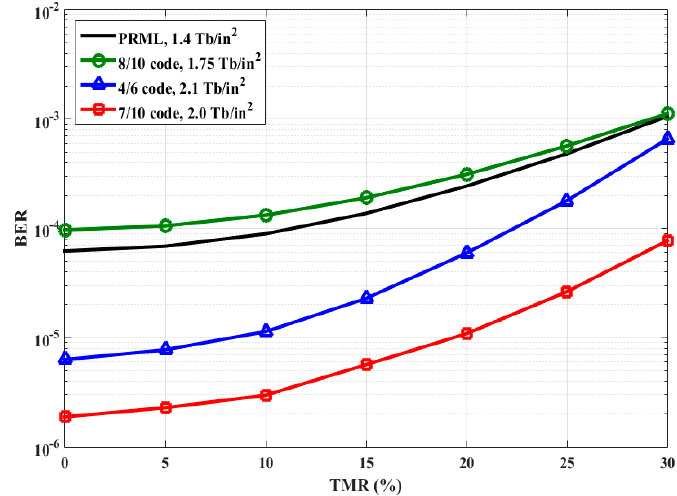
Figure 8. BER performance depending on TMR from 0% to 30% when UD = 1.4 Tb/in 2 .